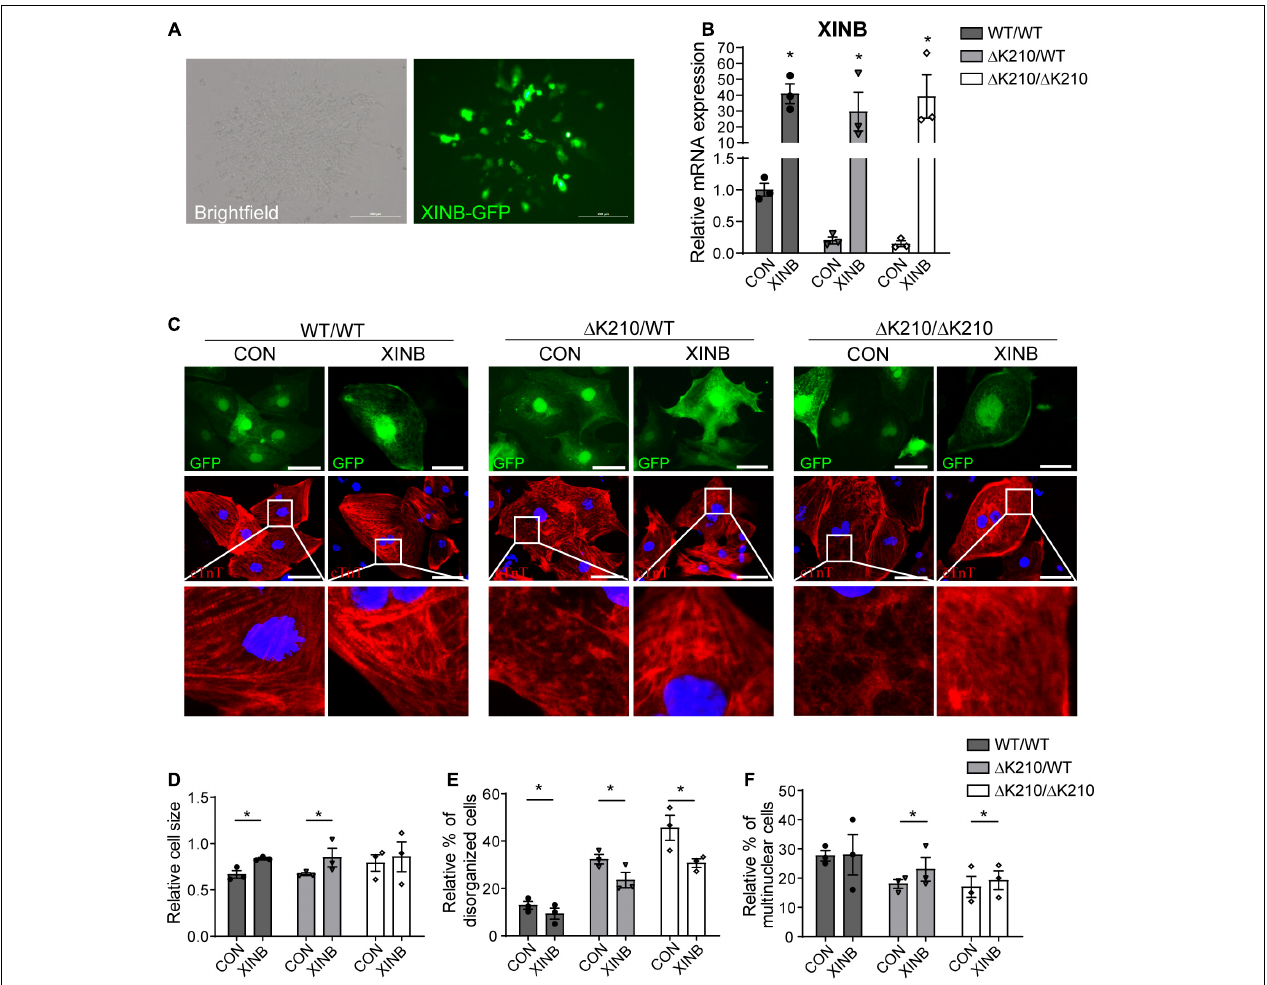
FIGURE 2 | Overexpression of XINB partially rescued the DCM phenotype of TNNT2 - (cid:49) K210 cardiomyocytes. (A) Brightfield and fluorescence images of hESC-cardiomyocytes illustrating green fluorescence protein (GFP) expression after XINB-lentivirus transfection. Scale bars, 200 mm. (B) Relative XINB expression in WT/WT, WT/ (cid:49) K210, and (cid:49) K210/ (cid:49) K210 cardiomyocytes determined by quantitative PCR. (C) Representative immunostaining of cTnT (red) in cultured WT/WT, WT/ (cid:49) K210, and (cid:49) K210/ (cid:49) K210 cardiomyocytes after XINB overexpression. Cells transfected with lentivirus expressing GFP were used as control. Scale bars, 50 mm. (D) Quantification of relative cell size and (E) statistics of the relative disorganized sarcomeric pattern for WT/WT, WT/ (cid:49) K210, and (cid:49) K210/ (cid:49) K210 cardiomyocytes after overexpression of XINB. (F) Percent of multinuclear cells increased after XINB overexpression in TNNT2 - (cid:49) K210 cardiomyocytes. n > 30, 3 lines in each group; data are represented as mean ± SEM. * P <